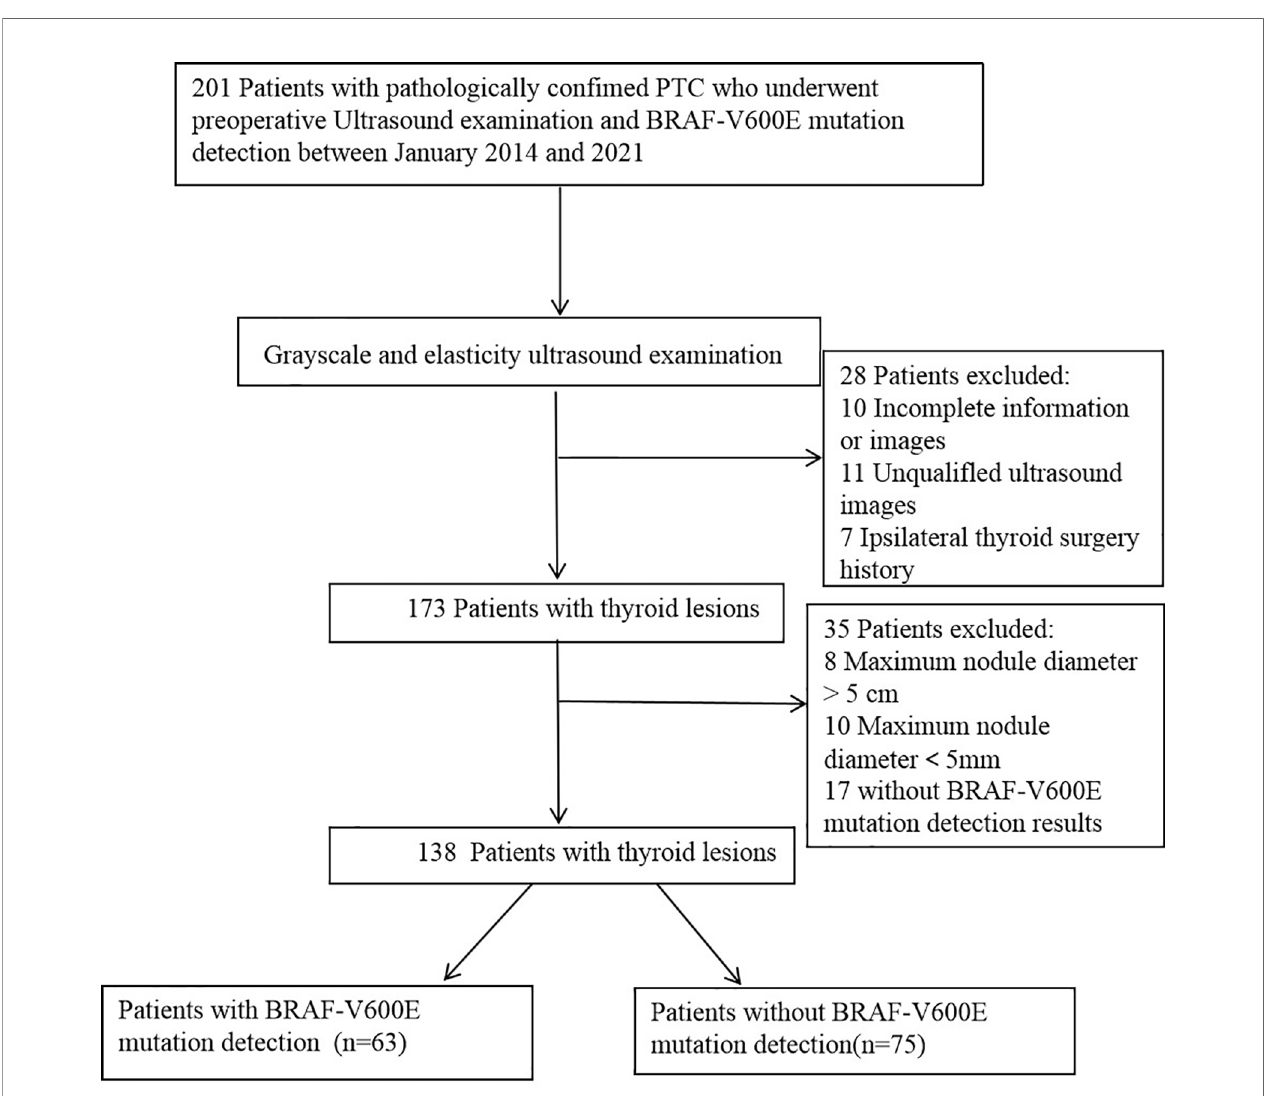
FIGURE 1 | Schematic diagram of the patient selection. PTC, papillary thyroid